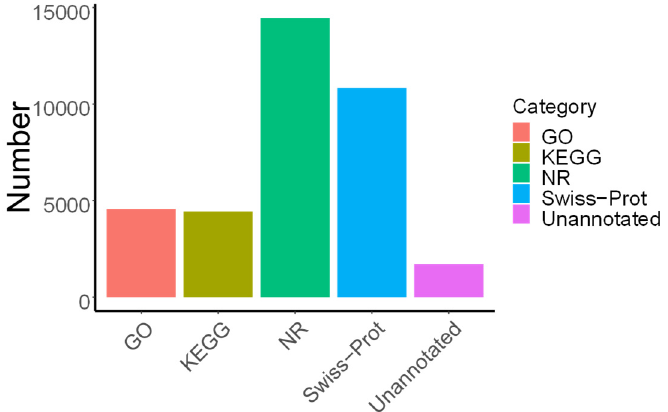
Figure 4. Annotation of the novel transcripts. There were more NR-annotated transcripts in comparison than the others, with the minimum number of transcripts left unannotated.